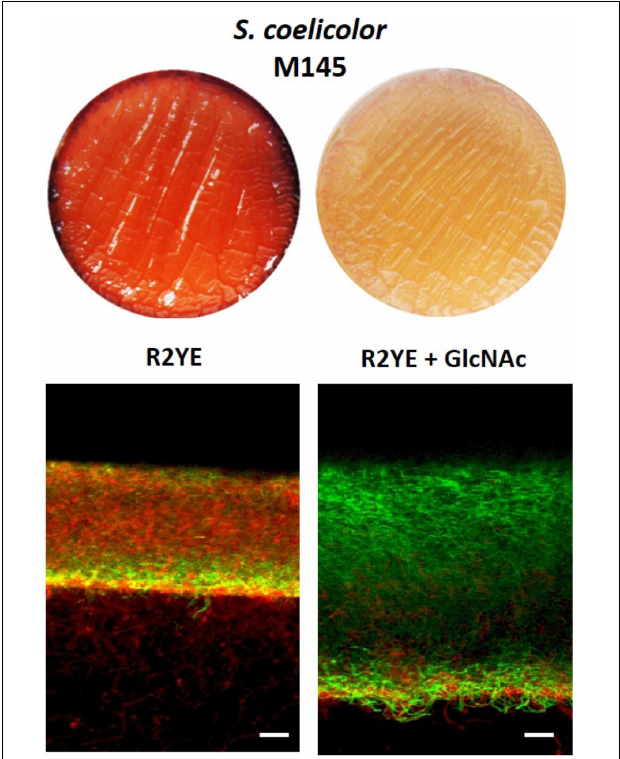
FIGURE 7 | Addition of the PdG biosynthesis inhibitor GlcNAc results in accumulation of viable filaments. Effect of GlcNAc (25 mM) on SYTO9 (green) filament staining, and PdG and PI (red) fluorescence. Bars, 20 µ m. S. coelicolor M145 was inoculated in R2YE agar